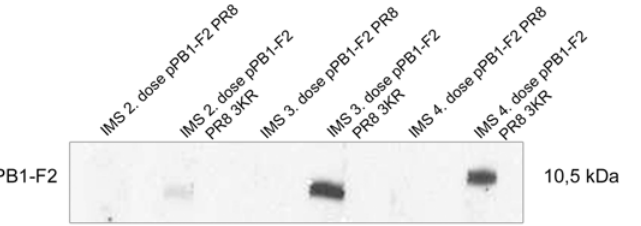
Fig 7. Antibody responses to pPB1-F2 PR8 vs. pPB1-F2 PR8 3KR after DNA immunization. The mice (n ═ 5) were immunized four times at two-week intervals with 50 μ g of pPB1-F2 PR8 or pPB1-F2 PR8 3KR DNA. MDCK cells were transfected with pPB1-F2 PR8 and lysed directly in the wells at 24 hr p. t. using SDS sample buffer. The proteins were separated through SDS-PAGE in a single well and transferred to nitrocellulose membrane. The sera were pooled after each dose and assayed for the presence of anti- PB1-F2 antibodies using immunoblotting on a sliced nitrocellulose